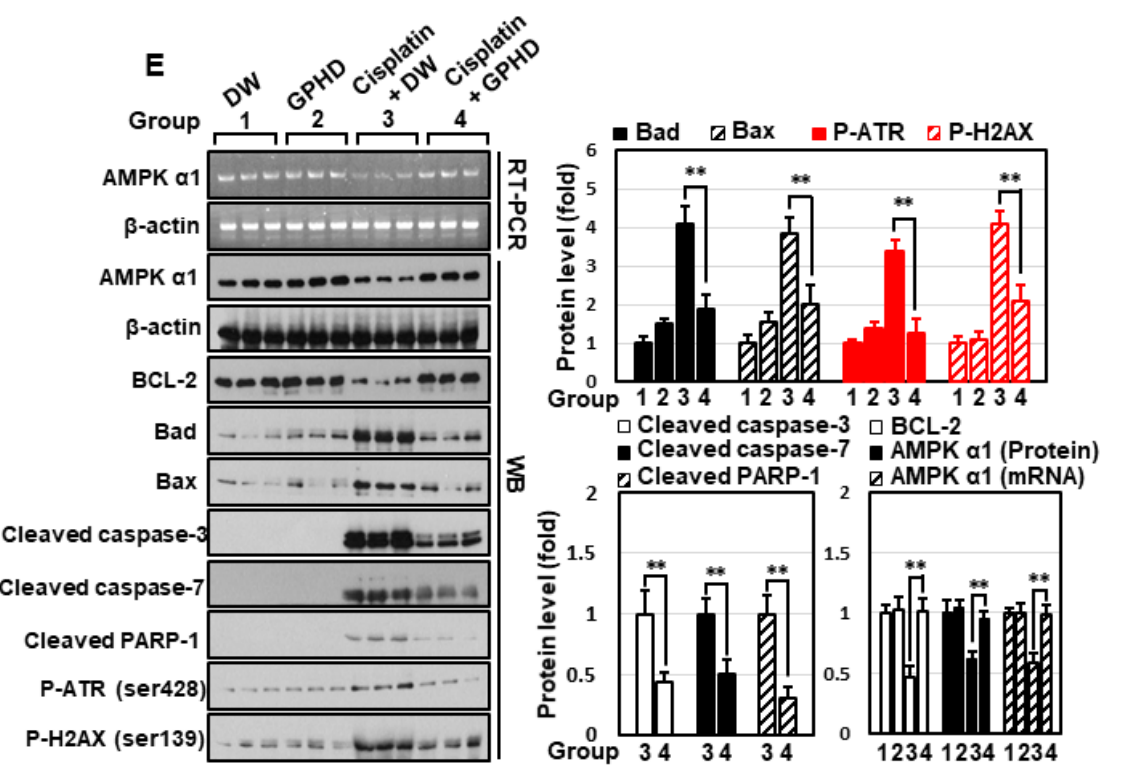
Figure 5. Effects of GPHD on cisplatin-induced AKI in mice. Four-week-old mice were fed a normal diet and GPDH or distilled water (~0.9 mL/d) for 28 days prior to intraperitoneal injection of cisplatin (20 mg/kg). Four days after cisplatin injection, mice were sacrificed ( A ). Mice were weighed ( B ), blood urea nitrogen (BUN), creatinine, neutrophil gelatinase-associated lipocalin (NGAL) in serum were measured ( C ), tissues were histologically examined by H&E, PAS, and TUNEL staining ( D ), and kidney tissue extracts were analyzed by Western blotting ( E ). p -value < 0.05 was considered statistically significant; individual p -values (* p < 0.05; ** p < 0.01) are indicated in